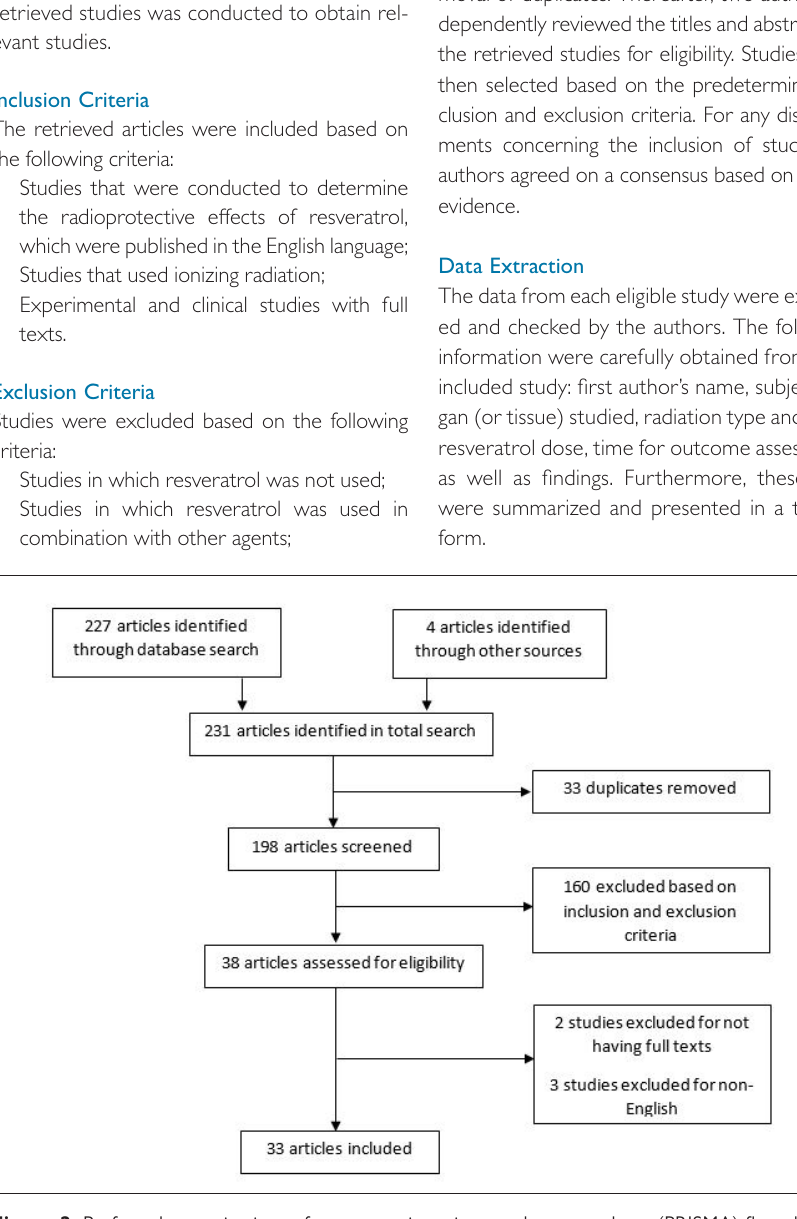
Figure 2. Preferred reporting items for systematic reviews and meta-analyses (PRISMA) flow diagram for the selection of included